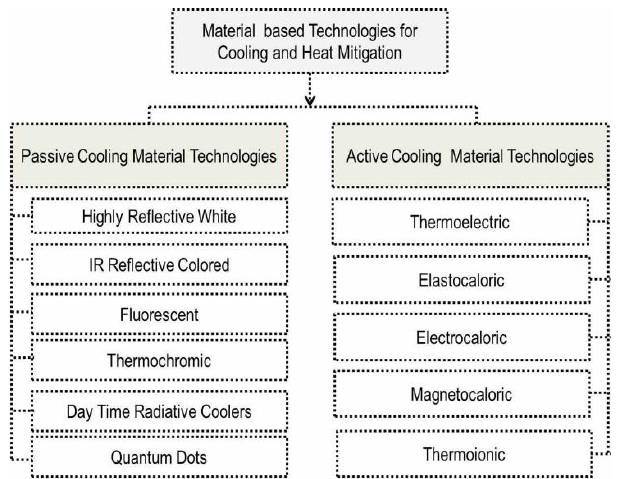
Figure 1. Classification of Materials for passive and active cooling.